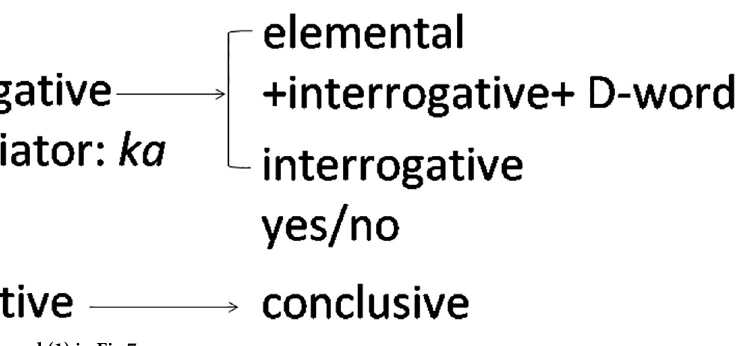
Fig 4. Indicative type, from the system network circled in red (1) in Fig 7.